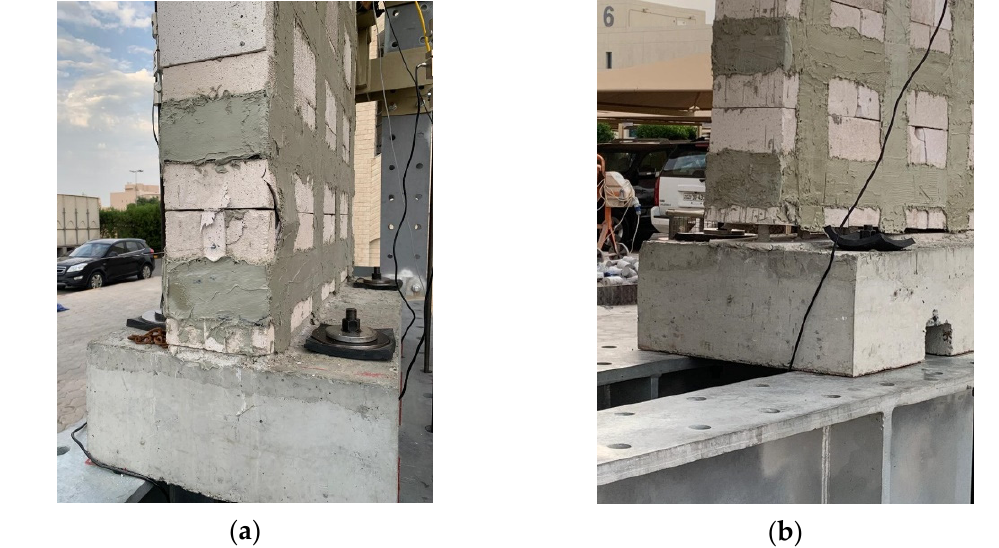
Figure 17. Failure of the reinforced wall ( a ) on the compression side and ( b ) on the tension side.